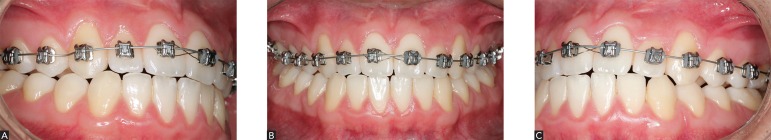
A) Initial treatment approach with leveling of maxillary arch
performed with stops placed on the mesial surface of molars, elastic ligatures on
anchorage teeth and the use of 0.014" heat-activated with anterior space between
teeth #11 and #14.